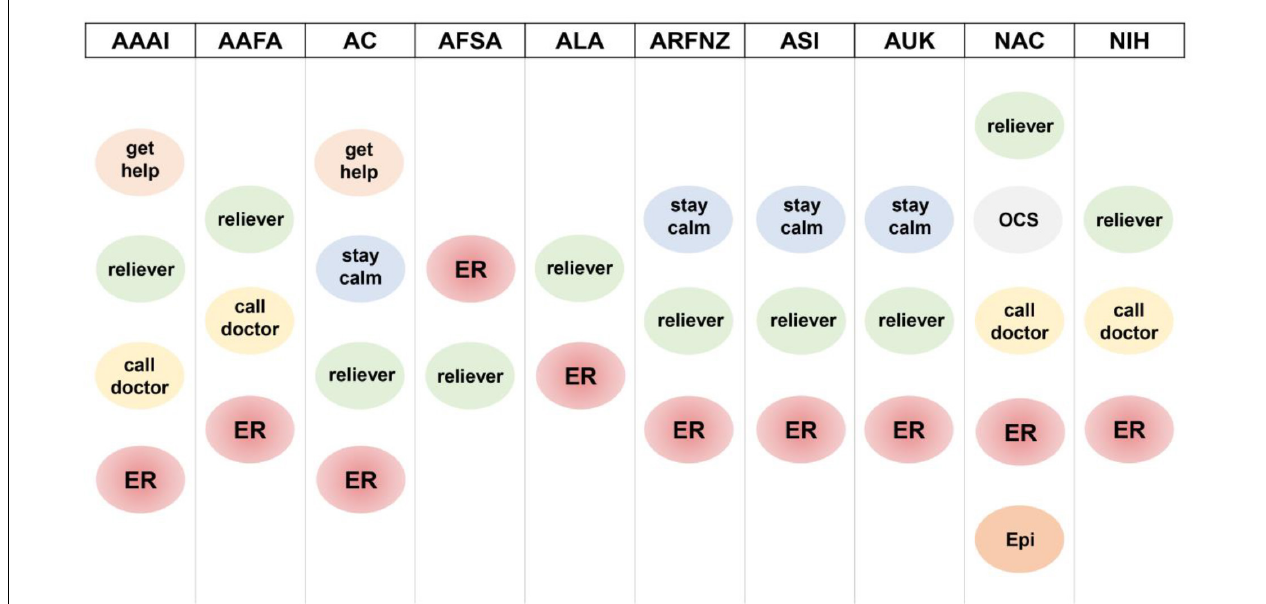
FIGURE 1 | Instructions provided by the action plans in case of acute asthma exacerbation. get help : the plan recommends seeking assistance (either medical or not) during an exacerbation; reliever : the plan recommends administering the reliever drug; call doctor : the plan recommends contacting the family/emergency physician; stay calm : the plan recommends not panicking and following the instructions included in the plan; ER : the plan recommends reaching the nearest emergency room; OCS : the plan recommends taking oral corticosteroids; Epi : the plan recommend administering epinephrine if indicated. AAAI, American Academy of Allergy Asthma & Immunology; AAFA, Asthma and Allergy Foundation of America; AC, Asthma Canada; AFSA, Allergy Foundation South Africa; ALA, American Lung Association; ARFNZ, Asthma Respiratory Foundation New Zealand; ASI, Asthma Society of Ireland; AUK, Asthma United Kingdom; NAC, National Asthma Council Australia; NIH, National Institutes of